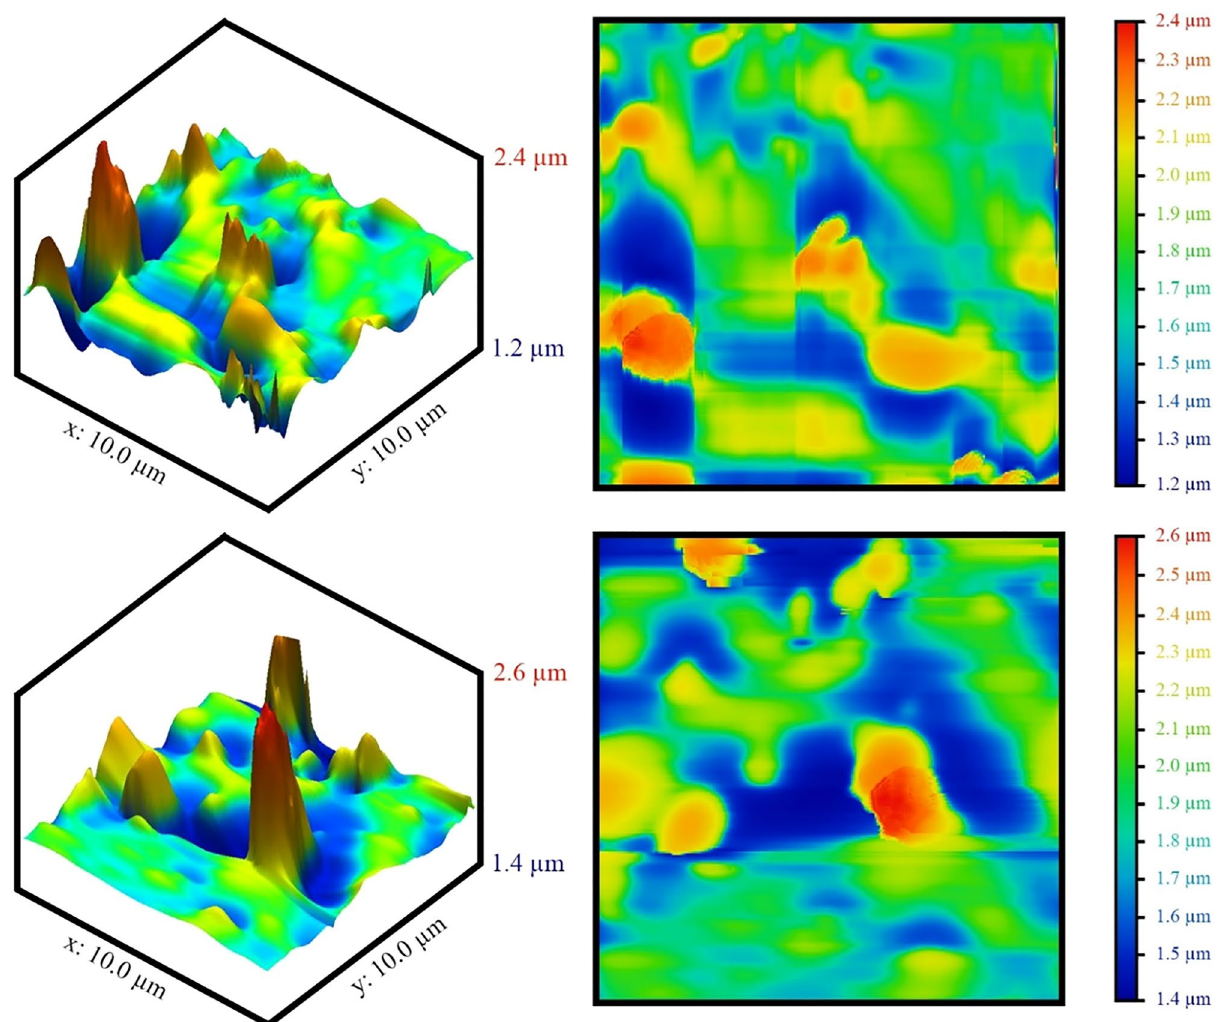
Figure 11. AFM images of the optimized